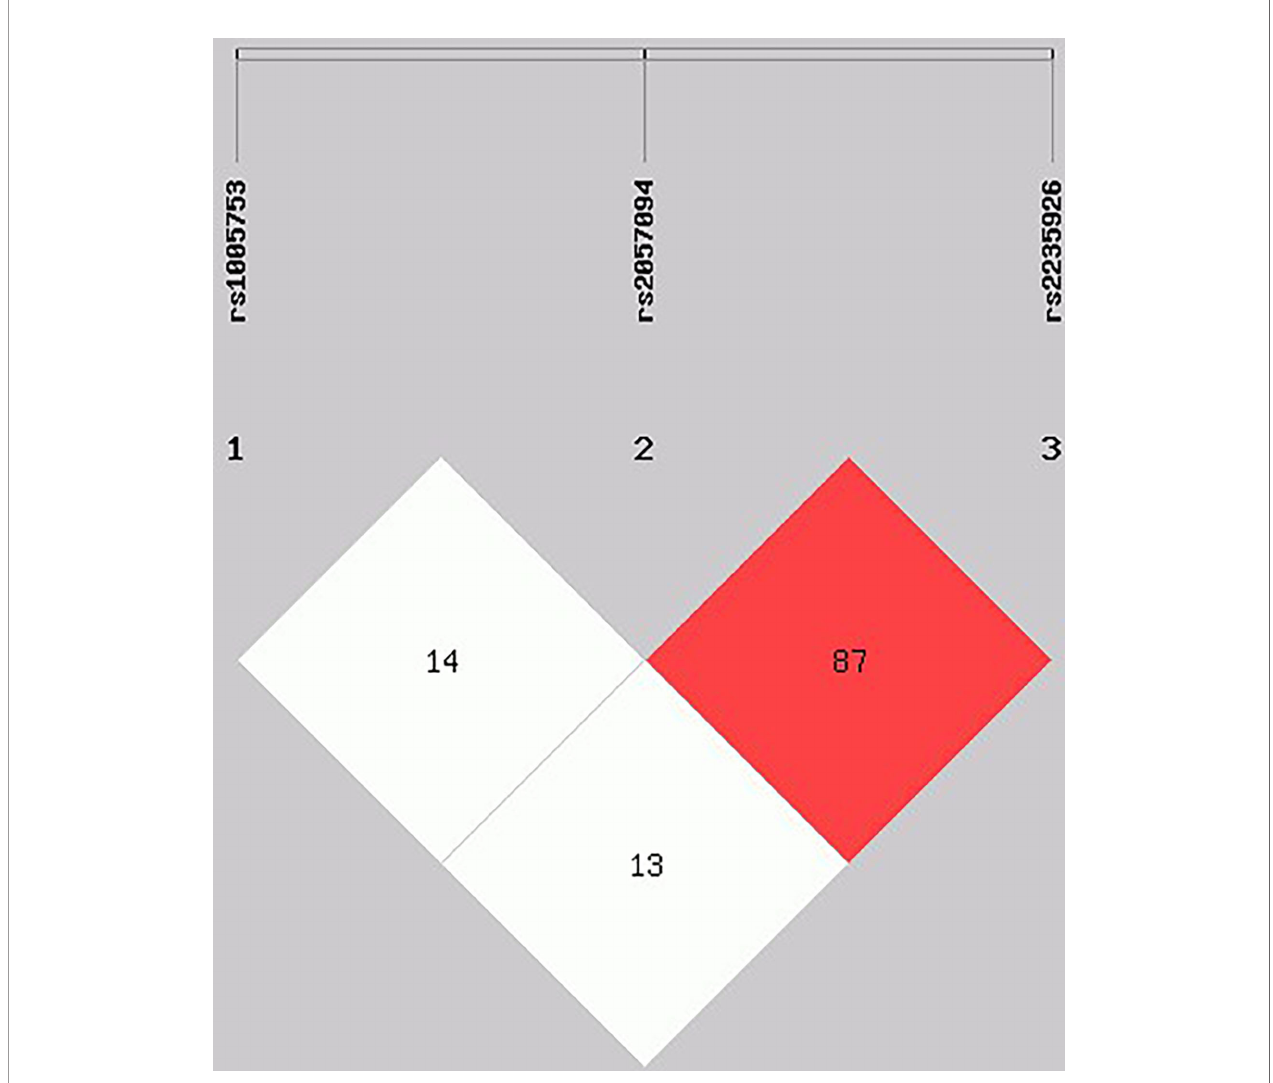
FIGURE 1 | Linkage disequilibrium (LD) test of PADI2 gene SNPs in RA patients. Haplotype frequencies and LD were calculated using SHEsis software. Red area represents higher levels of LD. A D´ value of 100 indicates a complete LD between two markers and a D´ value of 0 indicates complete linkage